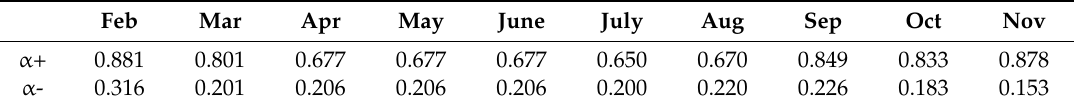
Table 1. Monthly averaged alpha weighting factors ( α + and α -) for mature almonds located in Belridge (CA, USA) during the period 2008-2011. Source: Blake Sanden, Cooperative Extension at the University of California, Davis.